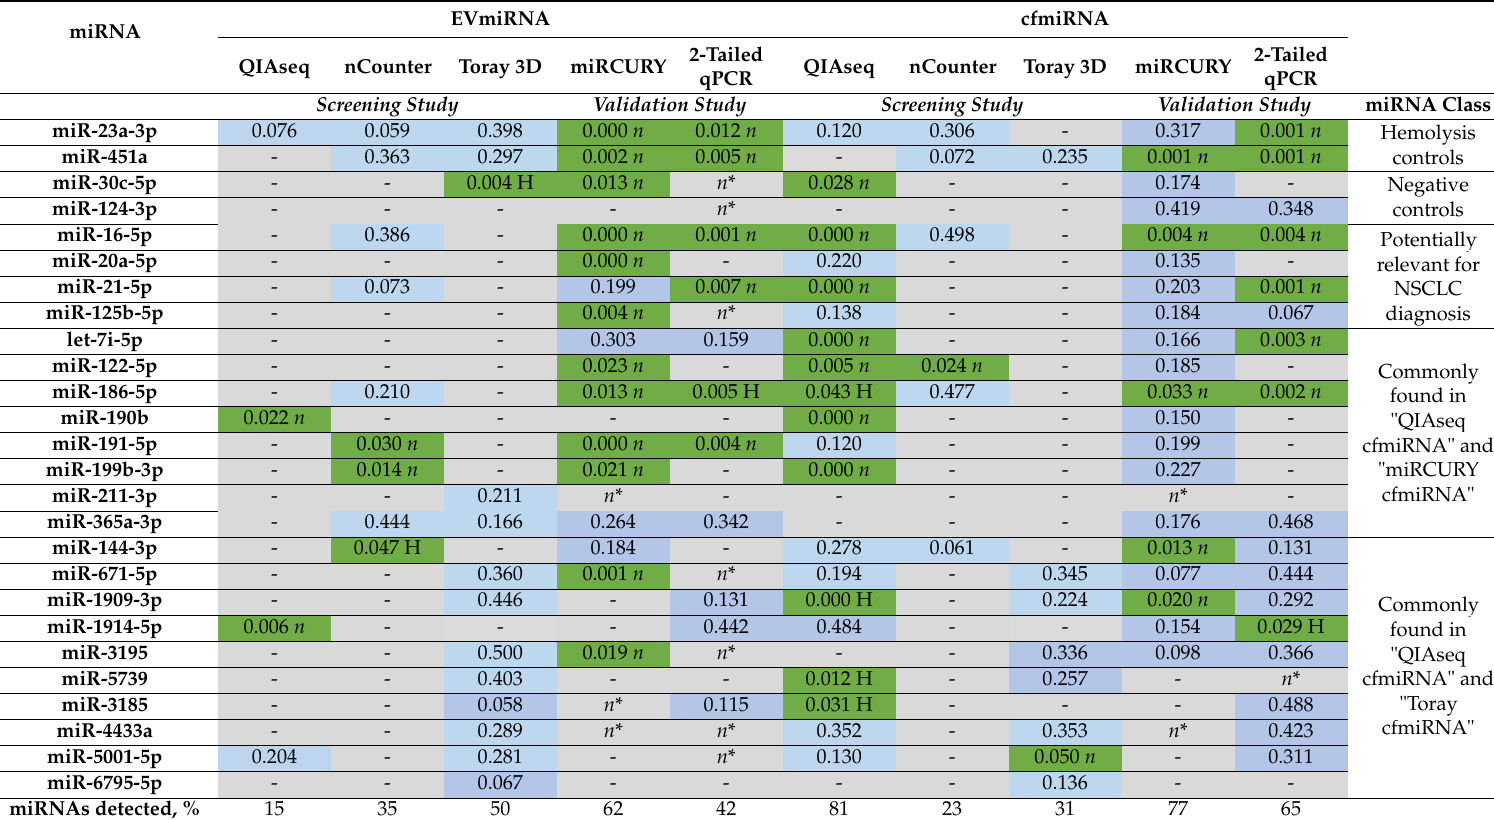
Table 1. Summary of di ff erent miRNA expression in healthy vs. NSCLC in the screening and validation phase for selected